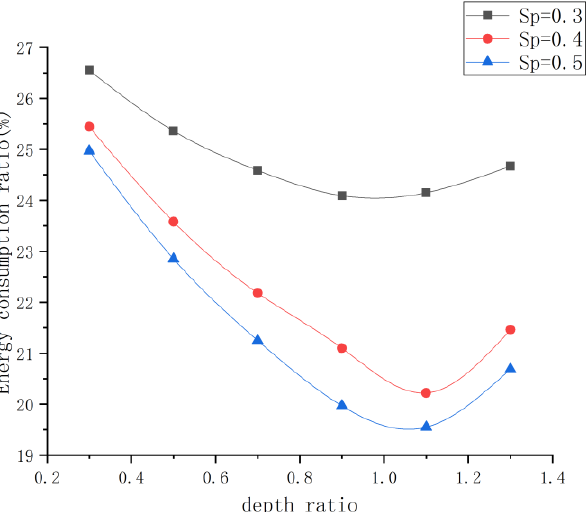
Figure 13. Energy consumption ratio with different depth ratio textured under varying area ratio textured.